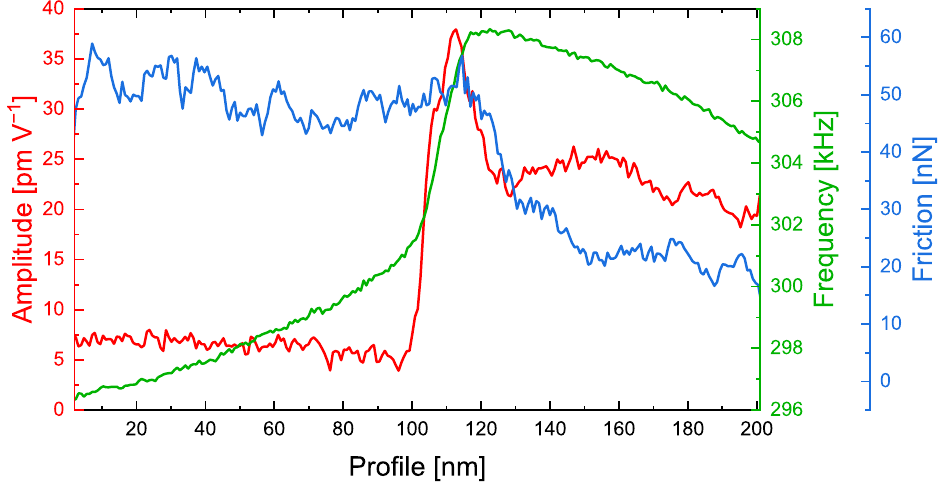
Figure 6. Corresponding line sections as highlighted in Figure 5 of the ESM amplitude, contact resonance frequency and friction force on a PEO sections are averaged over five